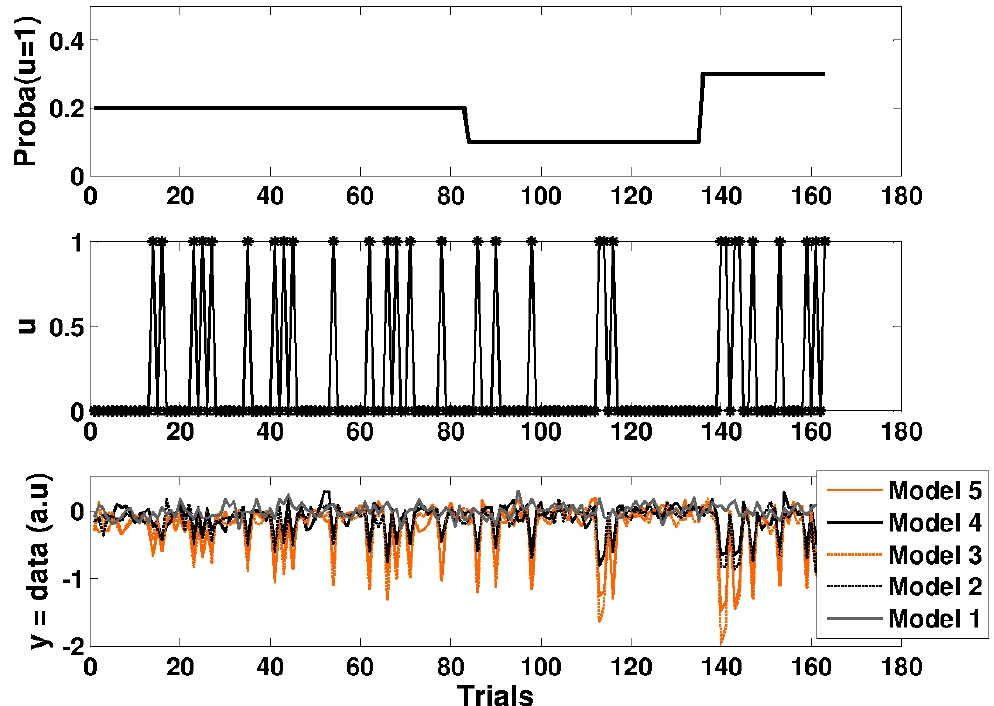
Figure 6. Simulated data for five Bayesian learning models (defined in Table 1). ( Top ) The dynamics of true deviant probability. ( Middle ) The sequence of sensory stimuli u (0 or 1). ( Bottom ) The dynamics of (noisy) Bayesian surprise (simulated electroencephalography (EEG) response magnitudes over